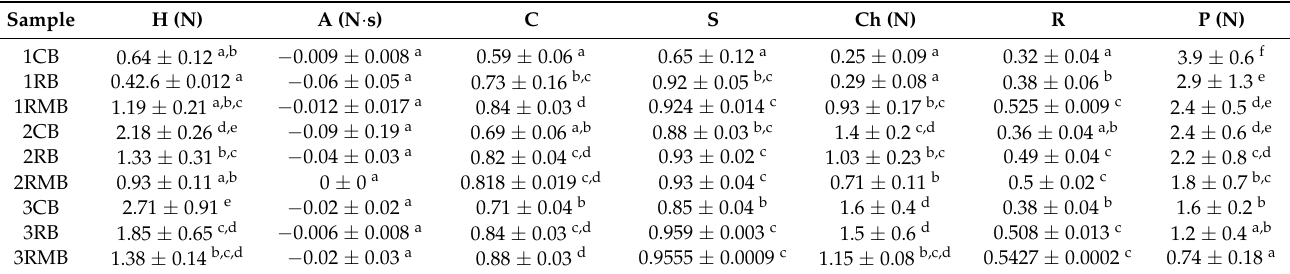
Table 4. TPA test parameters and crust